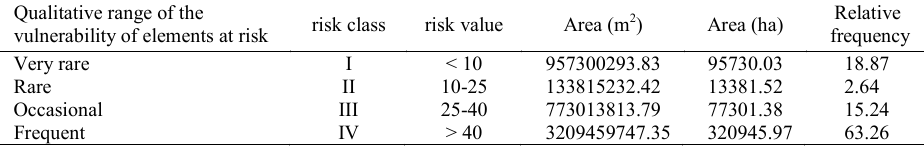
Table 14: Frequency distribution percentage of the risk classes of desertification in the area under study Qualitative range of the vulnerability of elements at